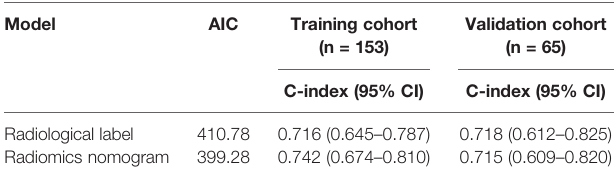
TABLE 3 | Discriminating performance of the radiological label and radiomics